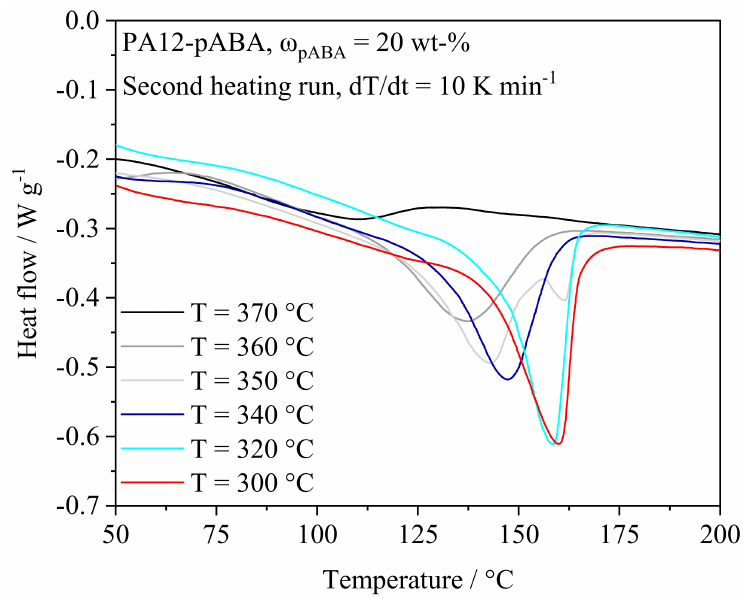
Figure 6. Differential scanning calorimetry of PA12-pABA, ω pABA = 20%, in dependence on the thermal history, t isothermal = 600 s, n = 3.